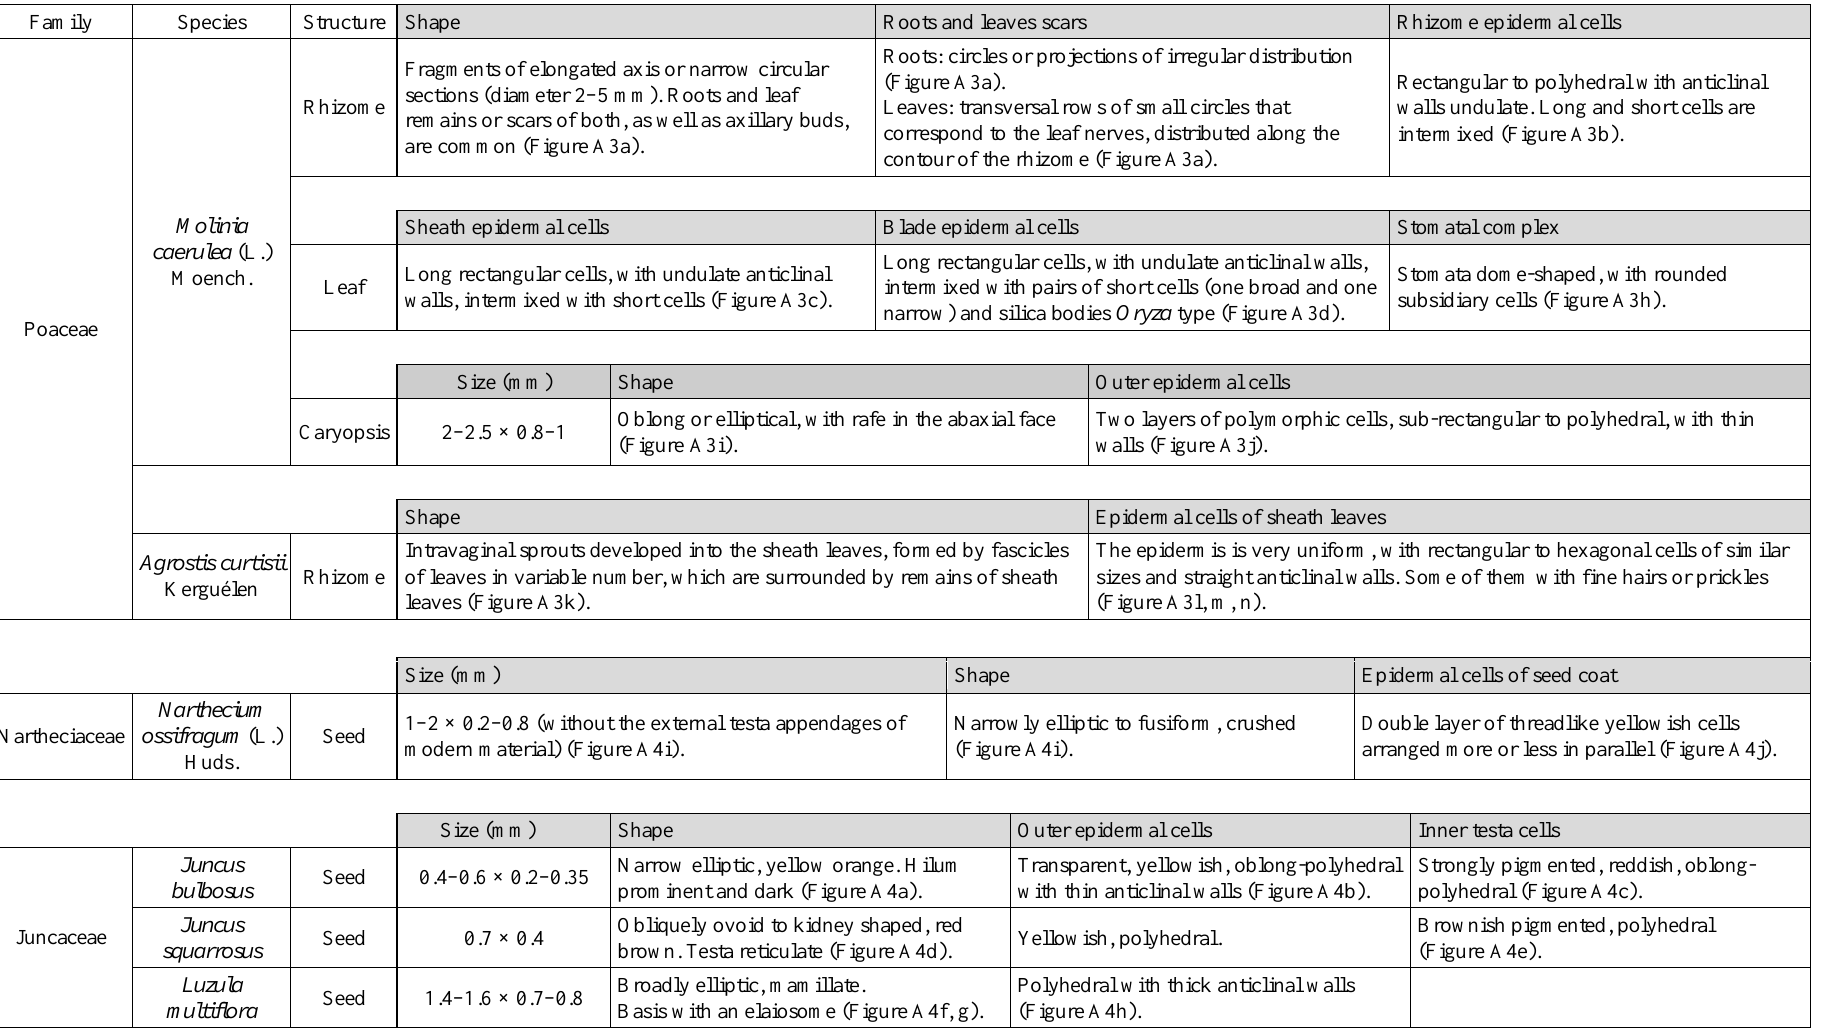
Table A2. Monocotyledons: Poaceae, Nartheciaceae and Juncaceae. Nomenclature of Poaceae follows Ellis (1979).